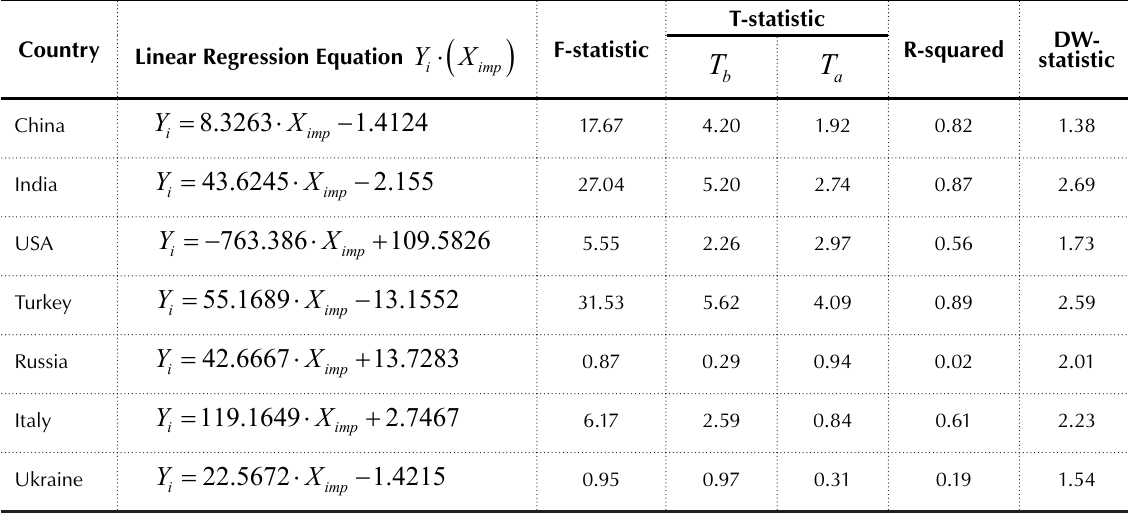
Country Linear Regression Equation